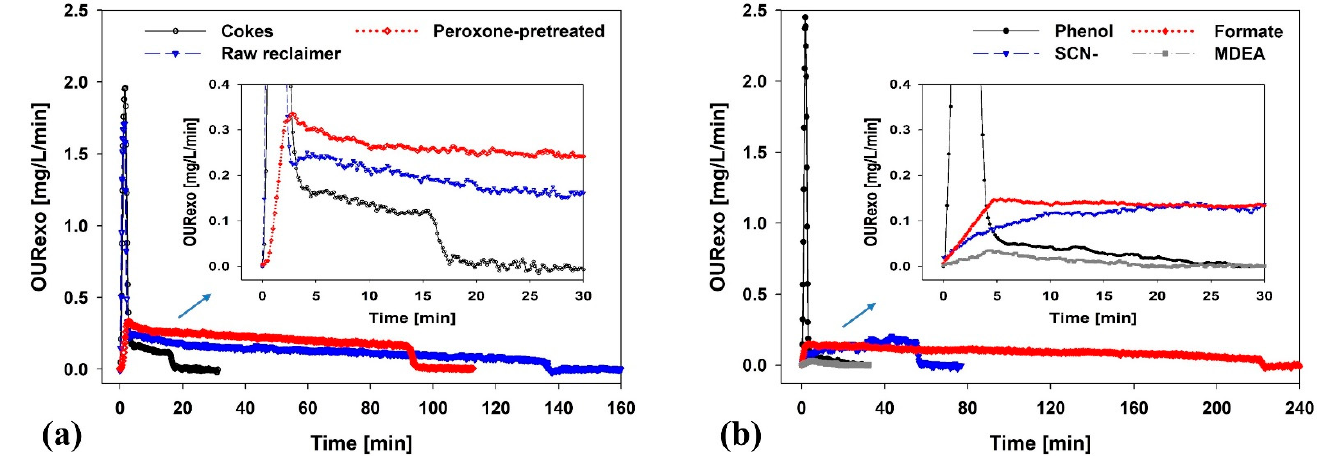
Figure 5. OUR exo profiles: ( a ) cokes, raw reclaimer, and peroxone-pretreated wastewaters; ( b ) phenol (1000 mg/L), SCN − (2500 mg/L), formate (20,000 mg/L), and MDEA (20,000 mg/L); 3 mL of samples were injected for all cases.